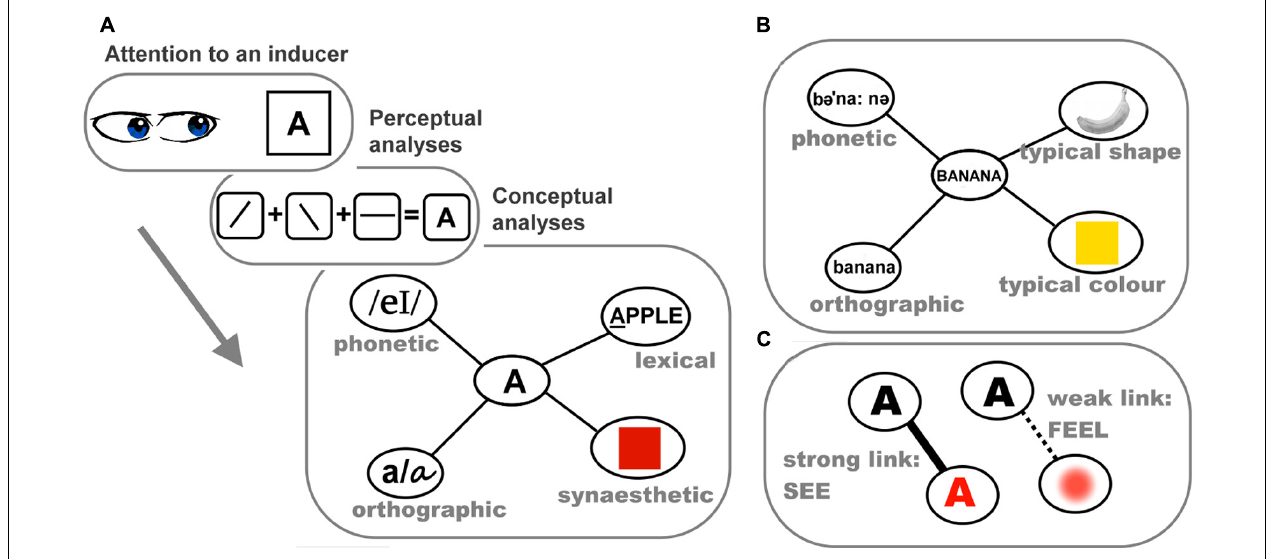
“A,” which in turn excites various associated nodes of conceptual properties in a semantic network, including its red synesthetic color; (B) a schematic illustration of the semantic network of the concept of banana and its related conceptual features; (C) the salience/vividness of synesthetic color may depend on the strength or directness of the link between the lexical presentation of “A” and its synesthetically red